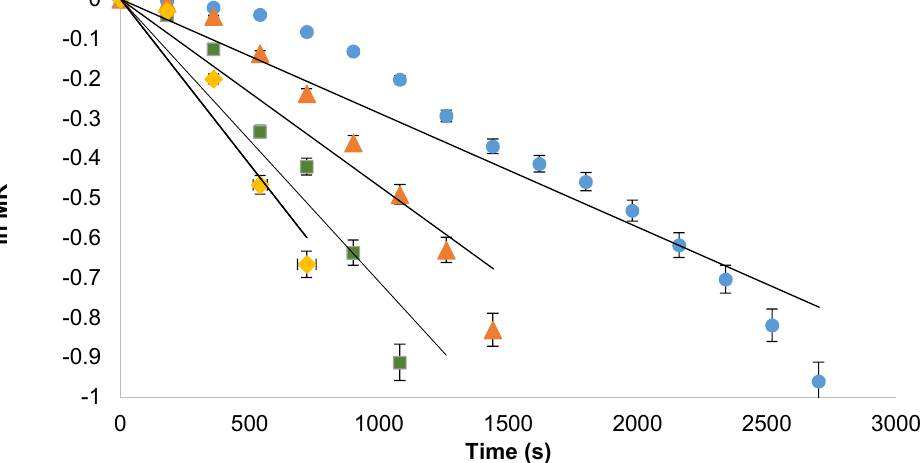
Figure 3. Graphical representation of ln MR as a function of time at various microwave powers; (◊) 100 W, (□) 80 W, (Δ) 50 W, and ( ○ ) 30 W. Table 2. E ff ect of microwave power on e ff ective di ff usivity, energy consumption and antioxidant activity.